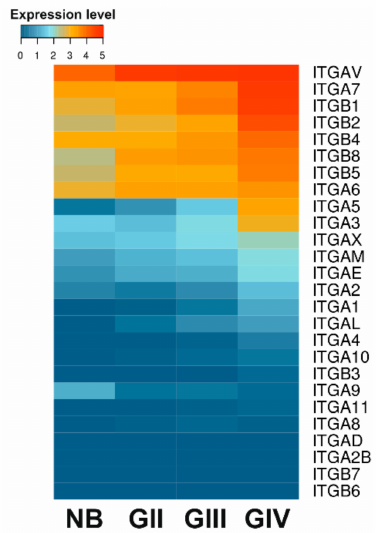
Figure 3. Expression profile of major integrin subunits. Data from 5 normal brain (NB) samples, 248 WHO grade II (GII), 261 WHO grade III (GIII) and 160 glioblastoma (GBM) WHO grade IV (GIV) tumor samples were acquired from TCGA RNAseq repository as FPKM values, quantile normalized and log2 transformed. Mean expression values were